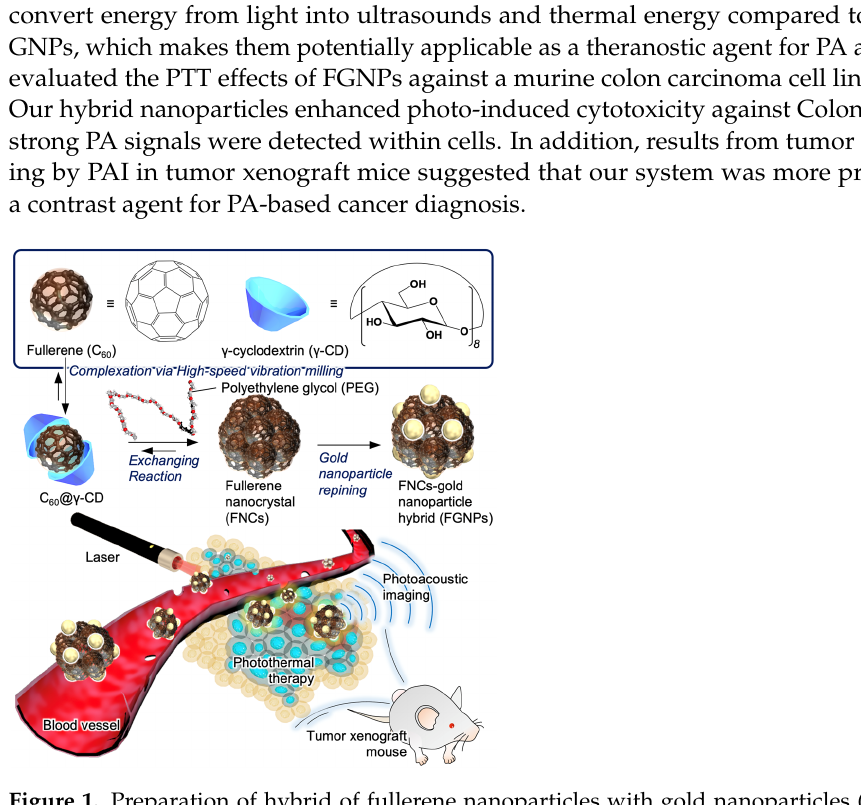
Figure 1. Preparation of hybrid of fullerene nanoparticles with gold nanoparticles (FGNPs) and tumor visualization with FGNPs by photoacoustic imaging.